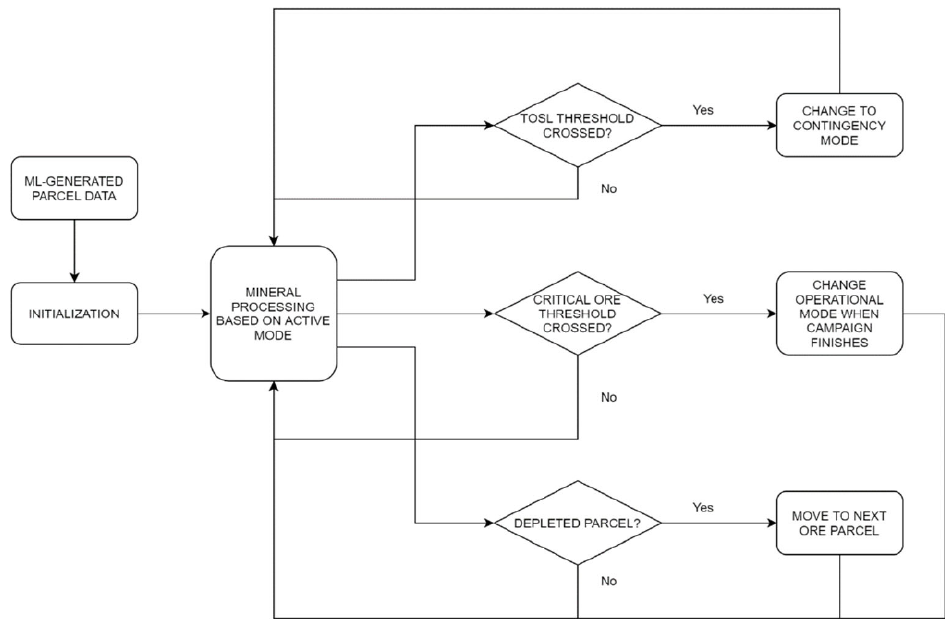
Figure 7. Generalized flow chart of the DES framework showing decision ‐ making logic for parcel loading and termination, operational mode changes and configuration rate changes (i.e., recourse actions). Abbreviations: ML = machine learning, TOSL = target ore stockpile level. Image from Peña ‐ Graf et al. [58].